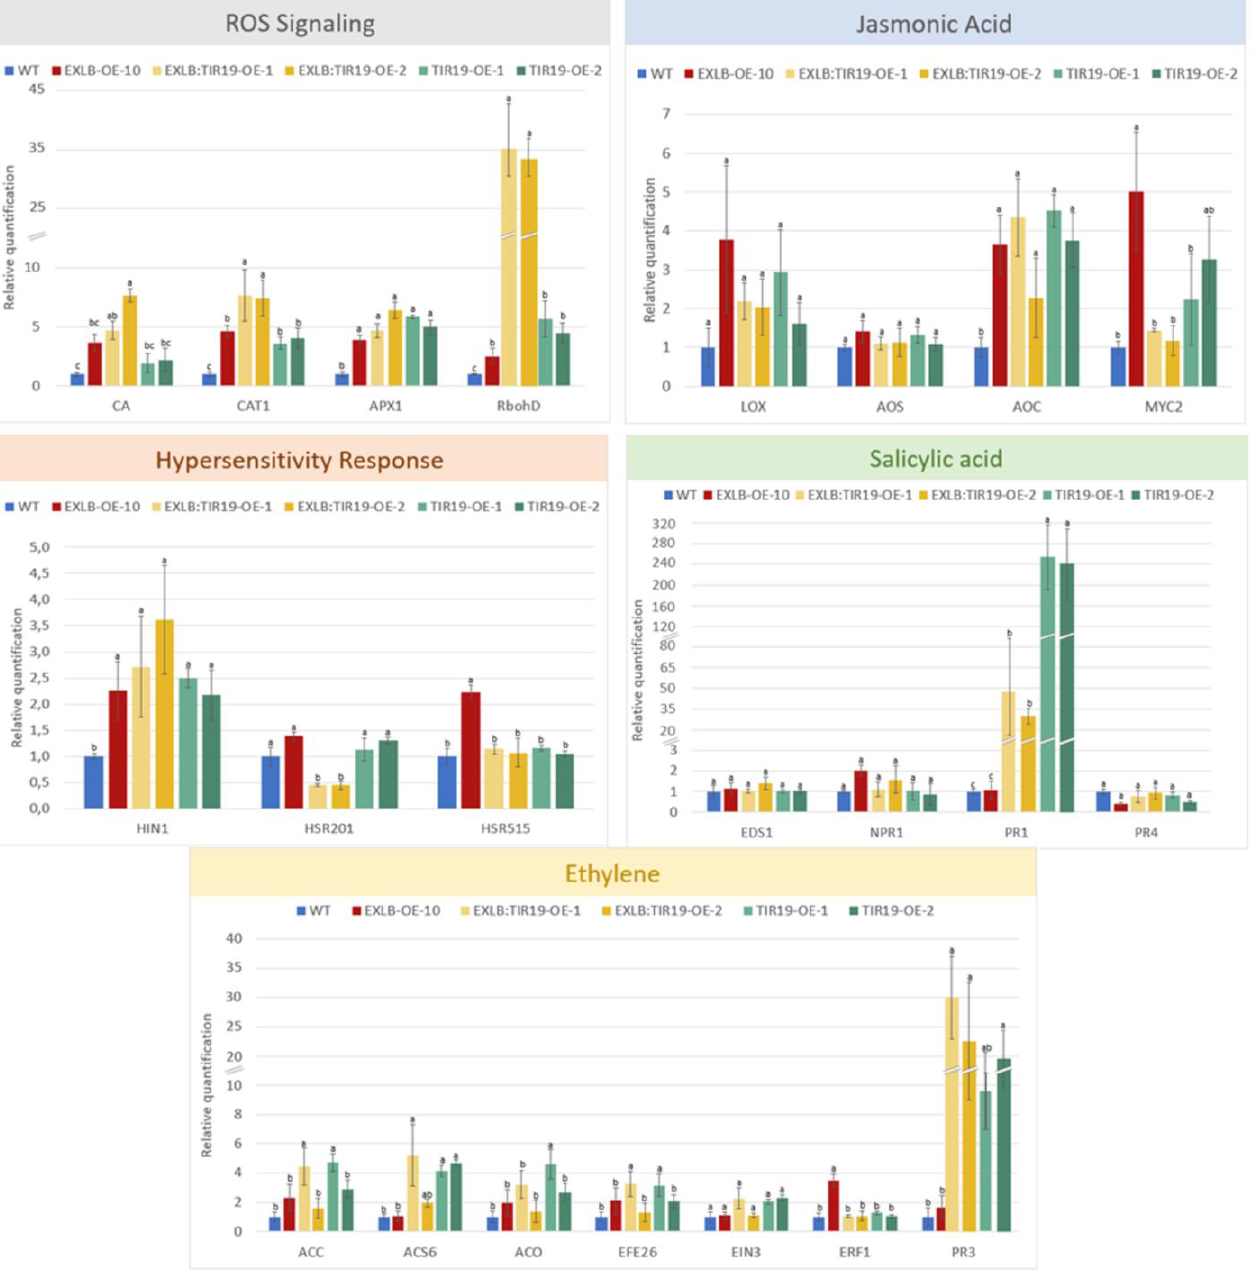
Figure 7. qRT‑PCR expression analysis of OE lines. Relative quantification of mRNA levels of 22 tobacco marker genes involved in plant hormonal (SA, JA, ET) and defense pathways (ROS and HR) in singly and pyramid OE lines relative to (wild‑type) WT plants. WT (blue); EXLB8‑OE‑10 (red), EXLB:TIR19‑OE‑1 (light yellow), EXLB:TIR19‑OE‑2 (dark yellow), TIR19‑OE‑1 (light green) and TIR19‑OE‑2 lines (dark green). Relative Quantification (RQ) values are means and standard errors of 18 individuals, with different letters indicating significant differences based in ANOVA followed by Tukey’s test ( p ≤ 0.05).